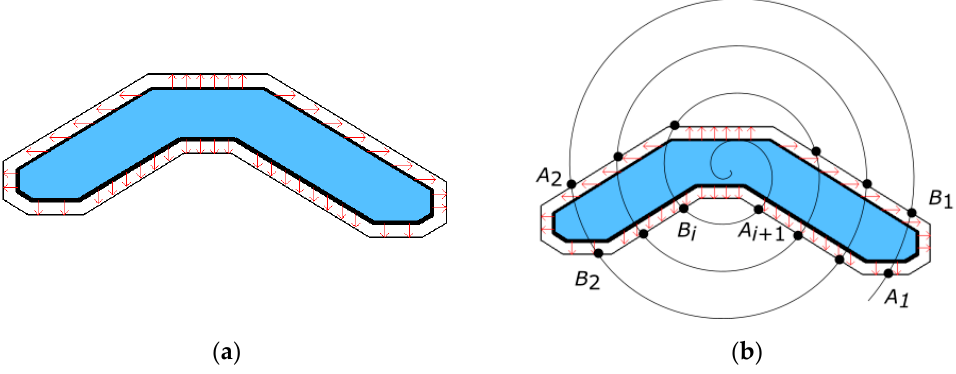
Figure 12. Spatial curve extension algorithm: ( a ) edge data extension and ( b ) data extension outside the boundary.